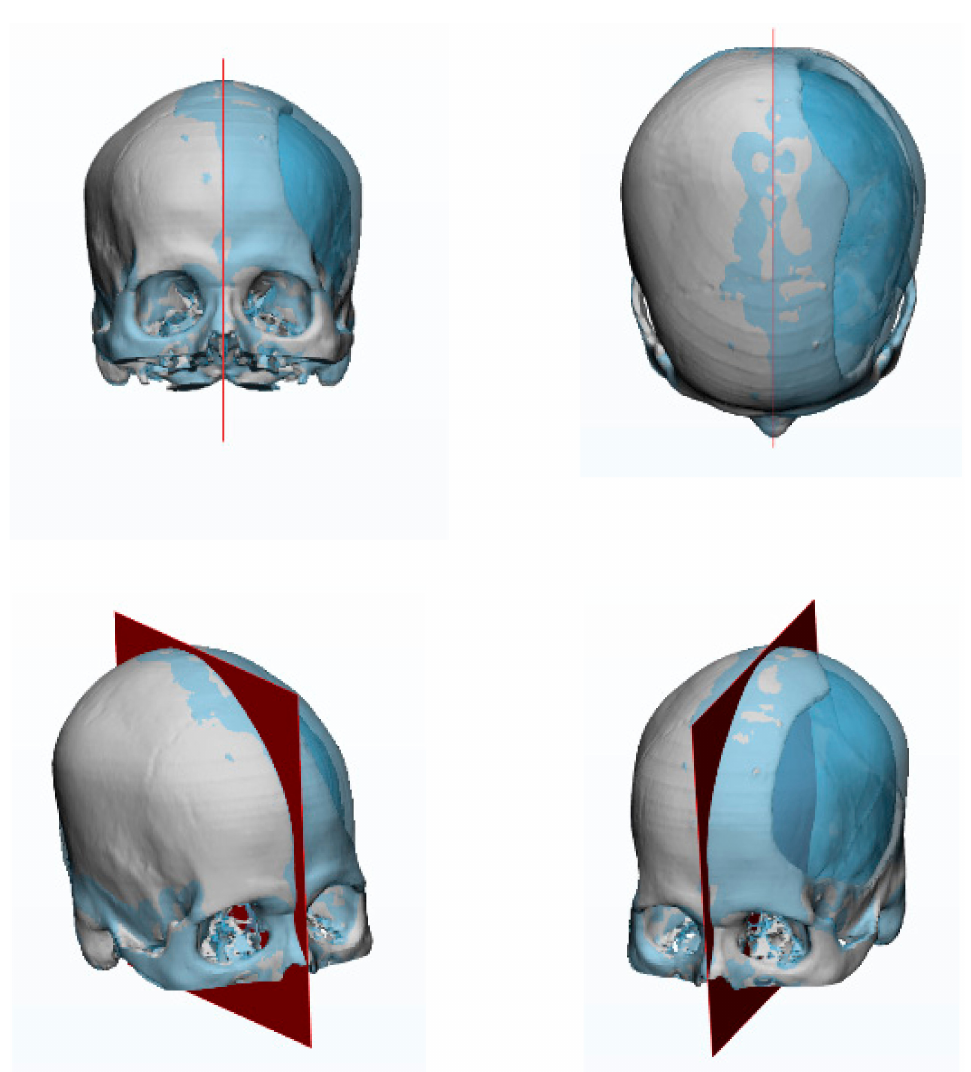
Figure 3. Final mirror plane (in red) was created by bisecting the two planes; initial and moved mirror planes. Complete reconstruction of the defected areas of each model was achieved after the